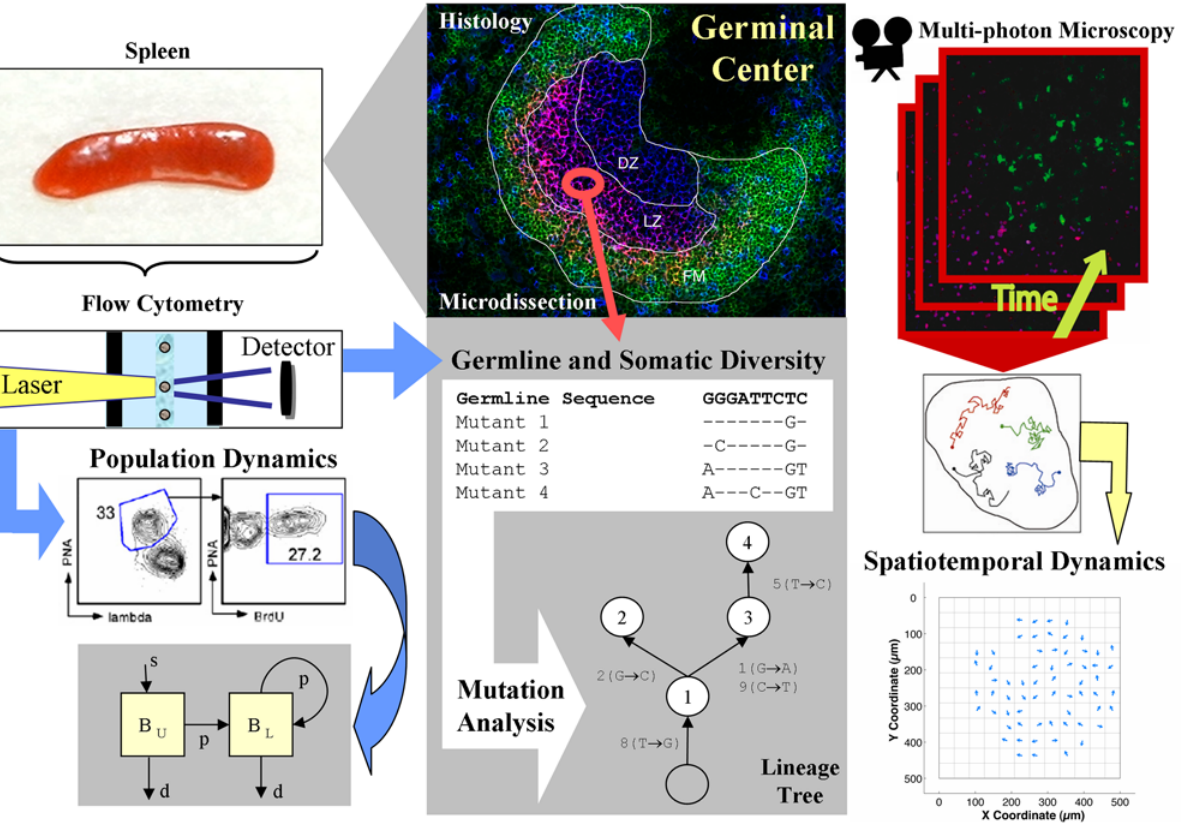
Figure 1. A wide range of experimental techniques are used in combination with computational modeling to probe the process of affinity maturation at multiple scales (from DNA to tissue). Population dynamics of splenic germinal center B cells is probed by quantifying labeled cells over time with flow cytometry (left panes). Microdissection of cells from tissue sections combined with sequencing of the Ig receptor provides information on germline receptor usage and somatic hypermutation (center panes). Histology is supplemented with intravital multi-photon microscopy to visualize and quantify spatiotemporal dynamics (right panes).